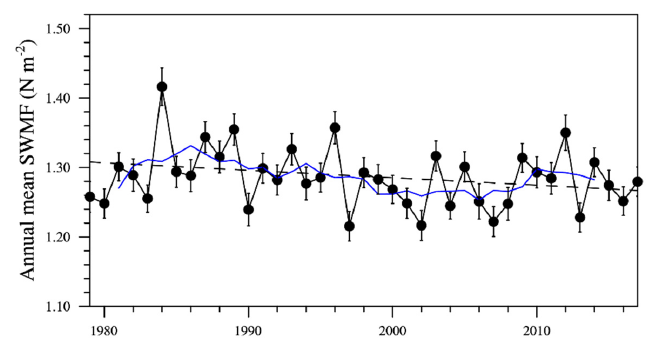
Figure 4. Time series of the annual-mean SWMF (units: N m − 2 ) over the TP during 1979–2017. Error bars represent standard errors. The blue line denotes the 5-yr running average, while the black dashed line is the linear trend during 1979–2017.